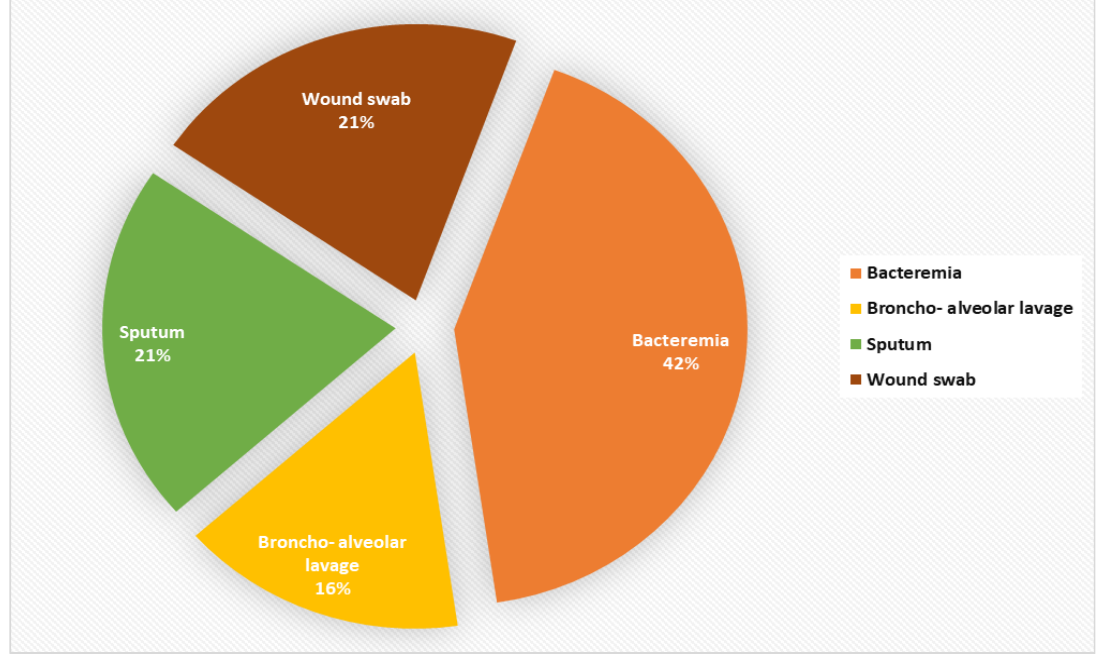
Figure 1. Distribution of the different sources of the 19 S. maltophilia